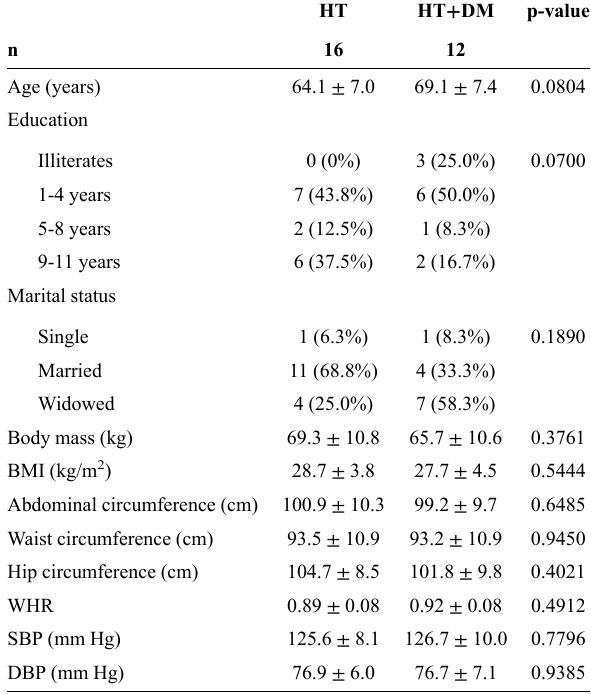
Table 1 - Characteristics of the